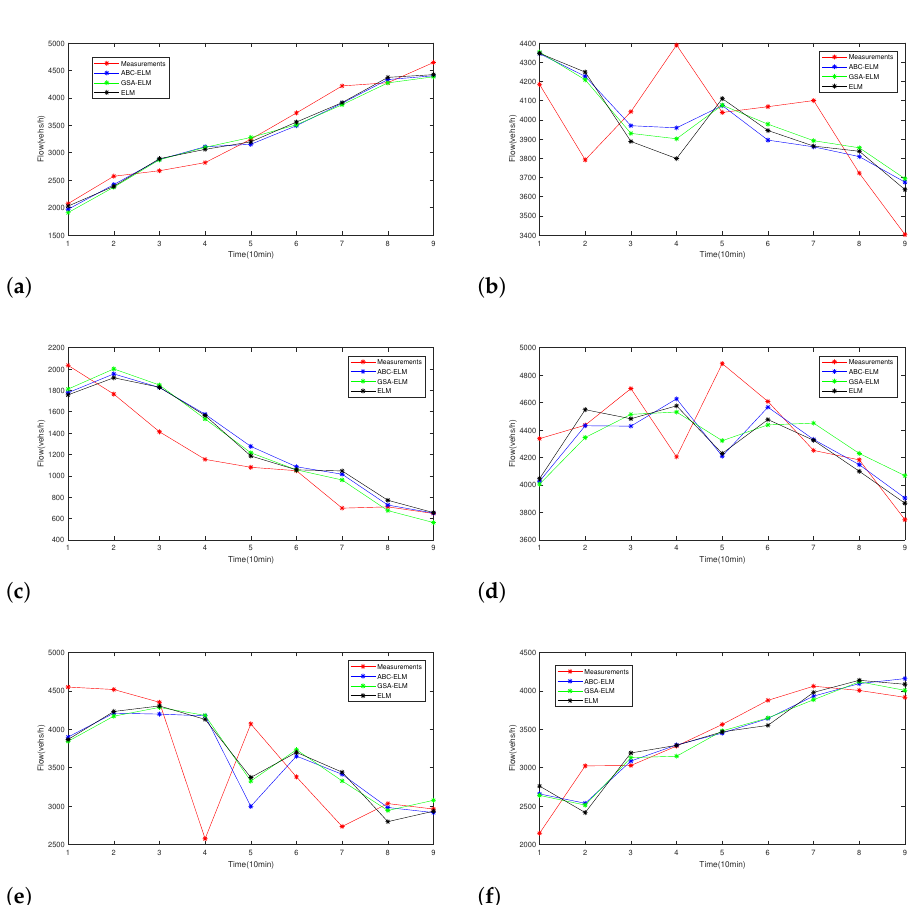
Figure 7. The part of ( a – f ) shows the performance of the three models under six different classical periods, respectively, where the classical periods include realistic scenarios, such as steady increases and sharp fluctuations in